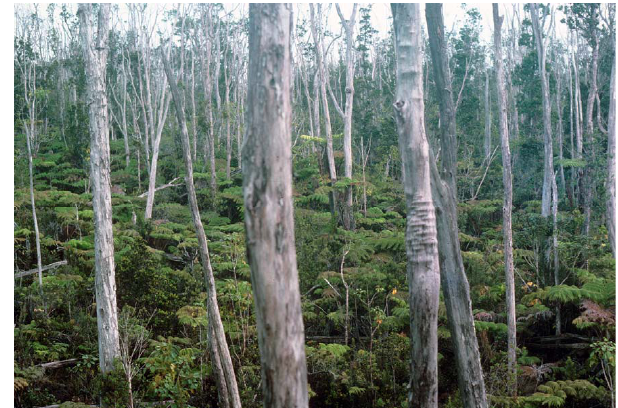
Fig. 5. Wetland dieback forest at a Tree Planting Road plot (photo by James D. Jacobi, 1976). 595